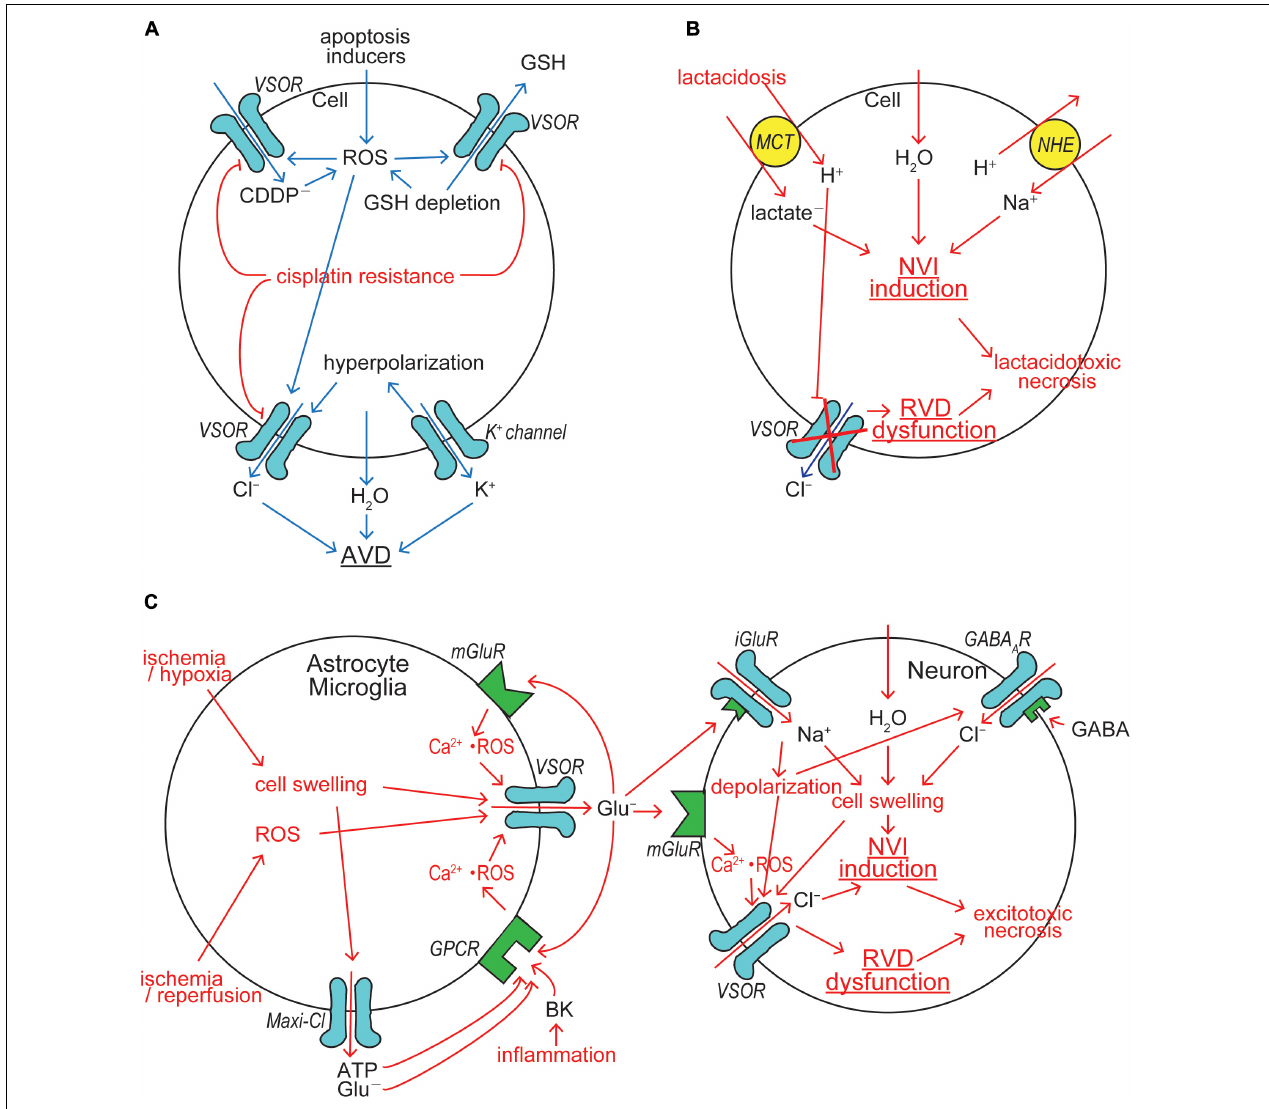
FIGURE 3 | VSOR/VRAC involvements in cell death induction/protection. (A) The mechanisms for AVD induction and cisplatin resistance acquisition. VSOR contributes to AVD induction by mediating Cl − efflux, GSH release and cisplatin (CDDP − ) uptake, whereas VSOR downregulation contributes to cisplatin resistance acquisition. (B) The mechanism for lactacidosis-induced NVI in neuronal and glial cells in which VSOR activity is abolished. (C) The mechanism for excitotoxicity-induced NVI in neuronal cells in which VSOR rather mediates Cl − influx under depolarization induced by activation of ionotropic glutamate